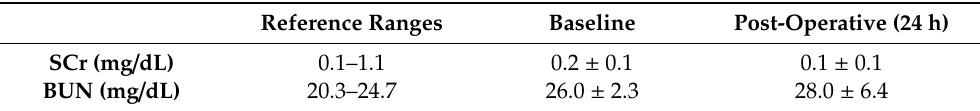
Table 1. Comparative markers of renal function pre and post injection. Serum creatinine (SCr) and blood urea nitrogen (BUN) in mice at baseline and 24 h after intra-arterial injection of